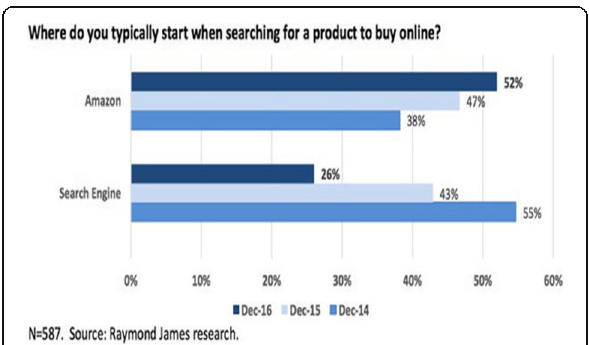
Fig. 1 Trends of using product by information